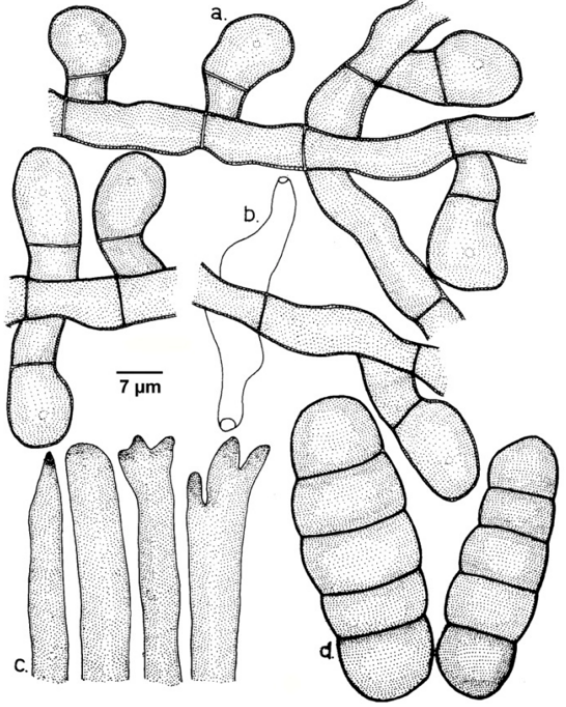
Figure 101. Meliola neolitseae a - Appressorium; b - Phialide; c - Apical portion of mycelial setae; d -